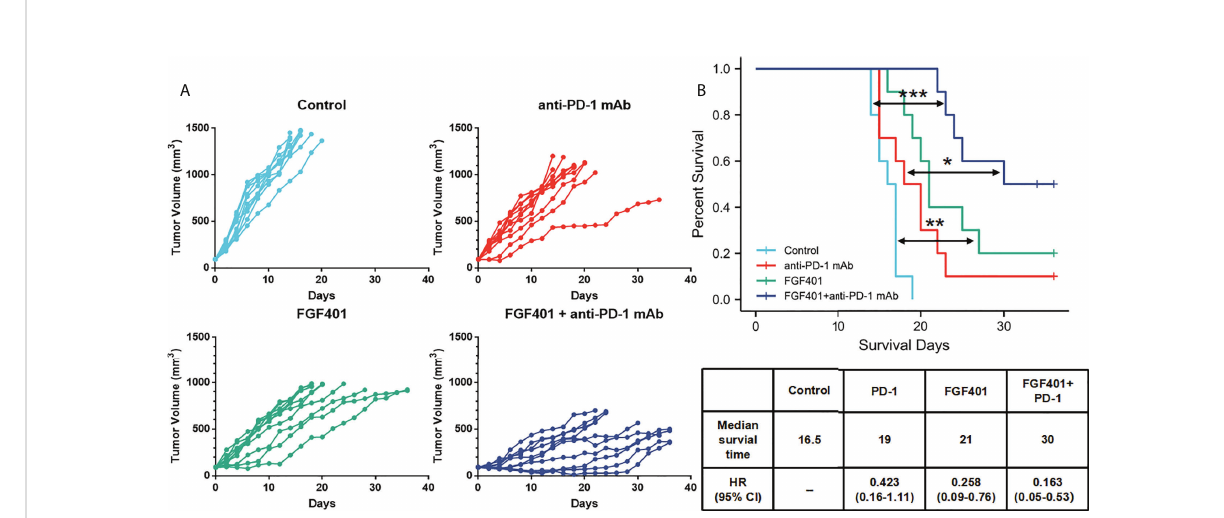
FIGURE 8 FGFR4 overexpression in the mouse model re-sensitized to anti-PD-1 mAb treatment in combination with an FGFR4 inhibitor. The N87-FGFR4 subcutaneous xenograft model was divided into different treatment groups either orally treated with FGF401 at 30 mg/kg once day or intraperitoneally injected with anti-PD-1 mAb at 200 mg/mouse twice weekly for 4 weeks, or both. (A) TVs of individual mice. Top left: control. Top right: anti-PD-1 mAb group. Bottom left: FGF401 group. Bottom right: FGF401 plus anti-PD-1 mAb treatment group. (B) Kaplan – Meier plots of mouse survival. Bottom, a table showed the median survival time of mice in different group and its HR (95% CI). (*p < 0.05; ** p <.01; ***p < 0.001, log-rank test between groups; TV, tumor